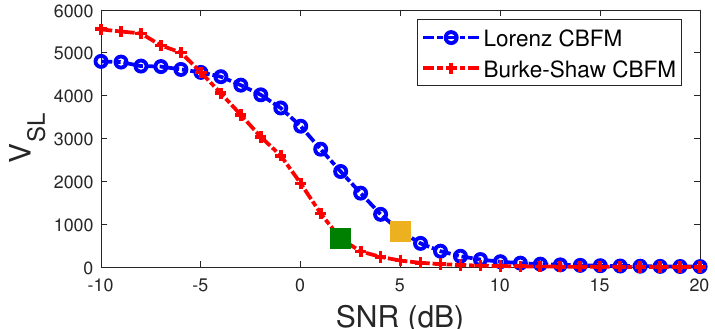
Figure 14. Sidelobe volume of the bistatic radar configuration for the Lorenz CBFM and Burke–Shaw CBFM waveforms plotted against the signal to noise ratio ( SNR ). The squares indicate that for the respective SNR, the sidelobe levels are at the value of − 13.33